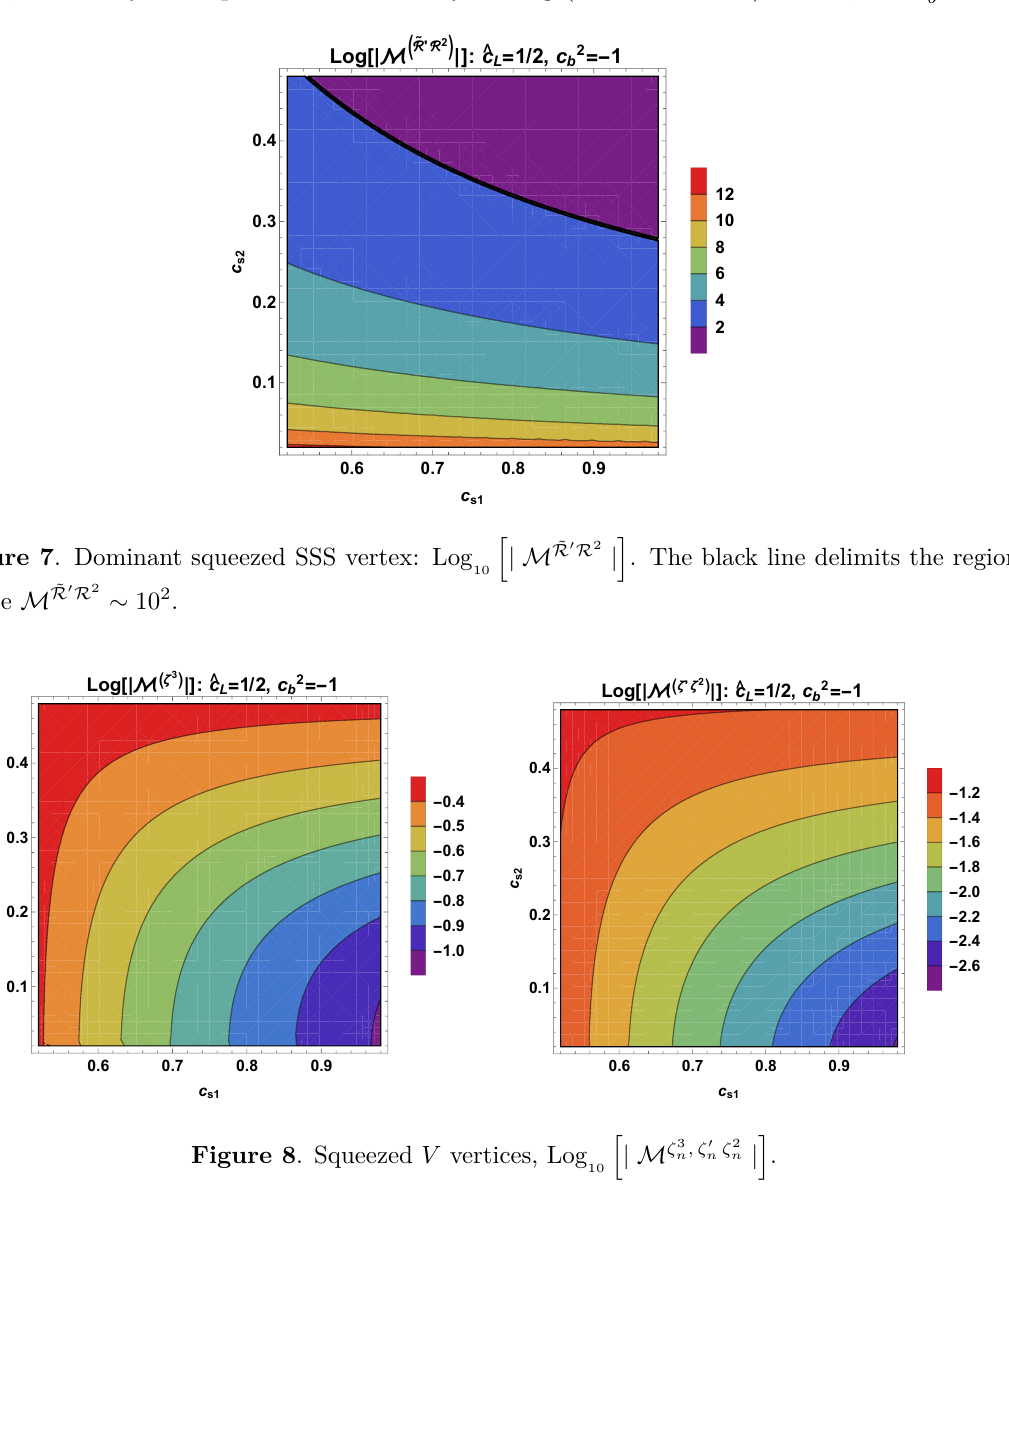
Figure 8 . Squeezed V vertices, Log